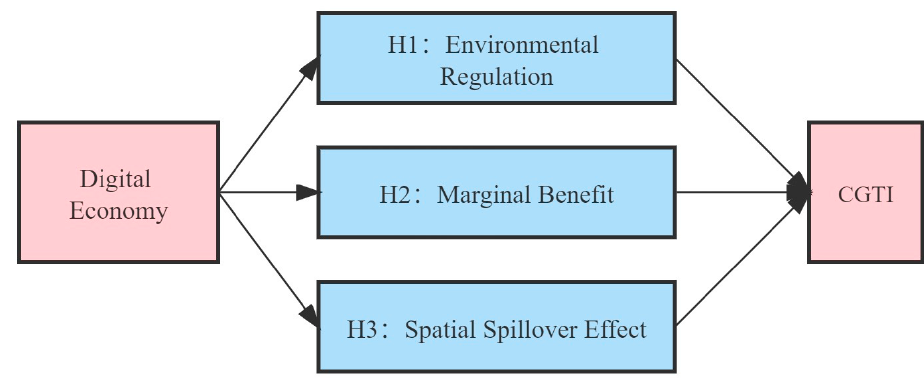
Figure 1. Theoretical model of this paper.